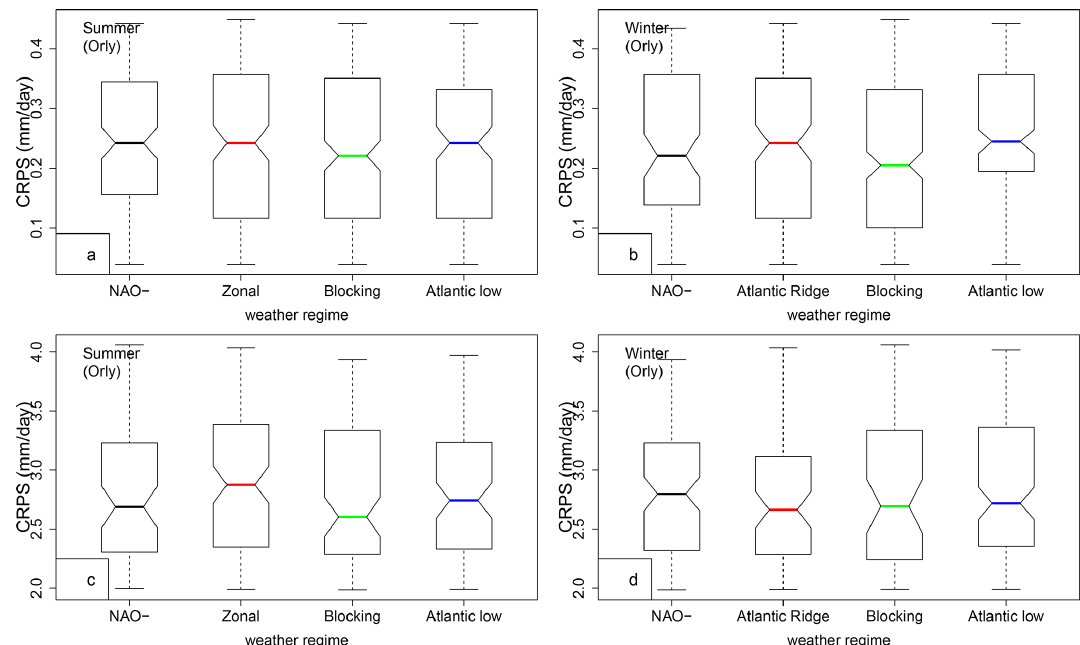
Figure 6. Relation between CRPS and weather regimes for Orly, for SWG forecasts with lead time T = 5d. Panels (a) and (b) show CRPS value distribution conditioned on four weather regimes, when CRPS is lower than q 25 . Panels (c) and (d) show that CRPS is higher than q 75 . The boxplots indicate the median ( q 50 ) of the distribution (thick bar). The 25th ( q 25 ) and 75th ( q 75 ) quartiles (lower and upper segments of each boxplot). The boxplot upper whisker is min { 1 . 5 (q 75 − q 50 ) + q 50 , max ( CRPS ) } . The boxplot lower whisker